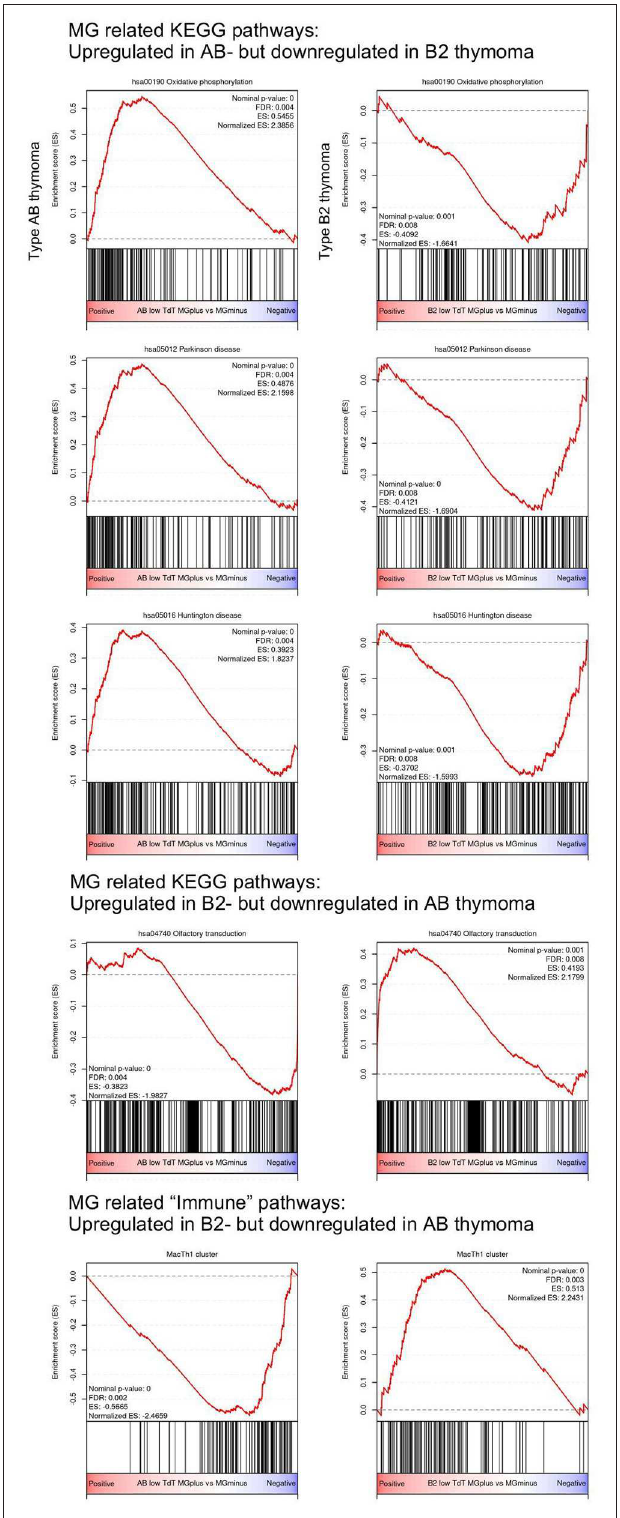
FIGURE 3 | Opposite upregulation/downregulation of MG-associated pathways in type AB and B2 thymomas based on Gene Set Enrichment Analysis (GSEA). Among the KEGG pathway, pathways related to “Oxidative